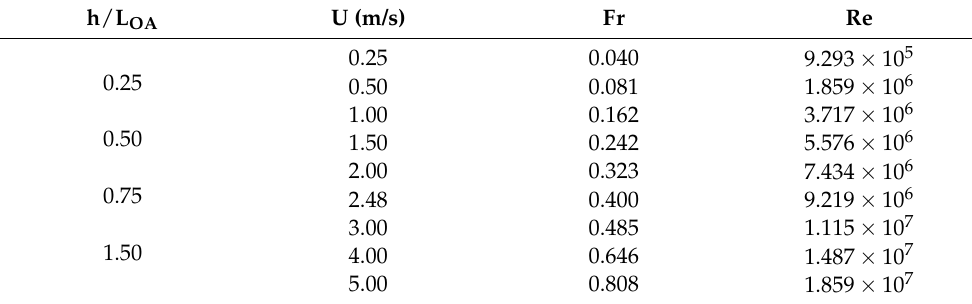
Table 3. Calm water hydrodynamic performance computations of full-scale WAM-V 16 geometry catamaran: test